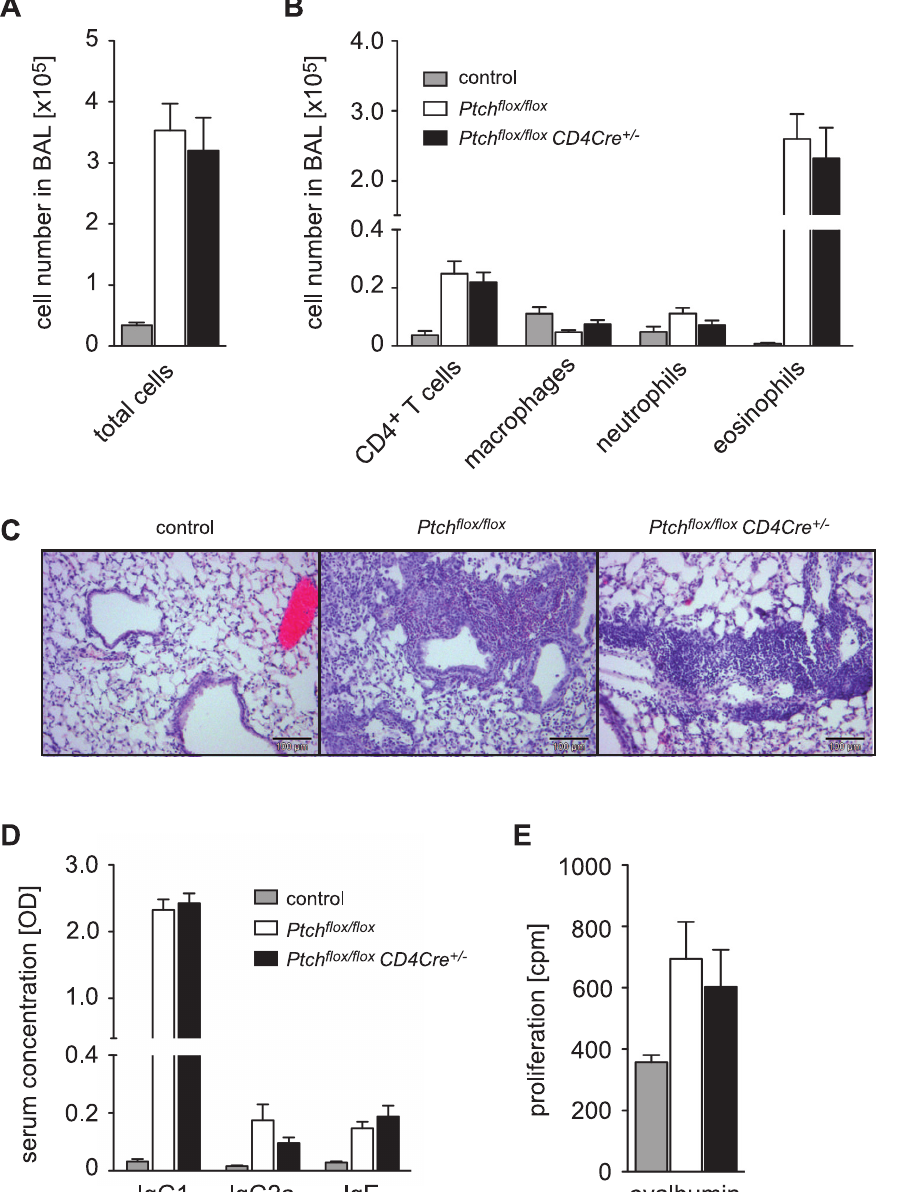
Figure 7. Lung infiltration, antibody production and T cell function after induction of allergic airway inflammation. Ptch flox/flox control and Ptch flox/flox CD4Cre + / 2 mutant C57BL/6 mice were sensitized against Ova by repeated intraperitoneal injection of antigen plus adjuvant. Control mice ( Ptch flox/flox ) received adjuvant without Ova. Antigen challenge was achieved by intranasal delivery of dissolved Ova for three consecutive days and analysis was performed after a two day resting phase. (A) Lungs were washed in situ and total cell counts in the broncheoalveolar lavage fluid (BALF) were determined using light microscopy. (B) Identification of different populations of lung-infiltrating cells within the BALF by using FACS. (C) Lung histology of mice 48 hours after the last challenge. A control lung obtained from a non-sensitized mouse challenged with Ova is shown along with lungs of Ptch flox/flox and Ptch flox/flox CD4Cre + / 2 mice which were both sensitized and challenged with antigen. No pathohistological signs of inflammation could be detected in control mice whereas a clear and massive cell influx was seen in sensitized and challenged mice. (D) Serum concentrations of Ova-specific IgG1, IgG2a and IgE immunoglobulins were quantified using ELISA and are depicted in the form of optical densities (OD). (E) Splenocytes were isolated and restimulated ex vivo with 10 m g/ml Ova for 72 hours and proliferation was assessed by 3 H-thymidine incorporation assay. Results represent the mean 6 SEM from nine non-sensitized control mice as well as thirteen Ptch flox/flox and fourteen Ptch flox/flox CD4Cre + / 2 animals, respectively. Statistical analysis of all parameters was performed by unpaired t-test and no differences were found in any case.